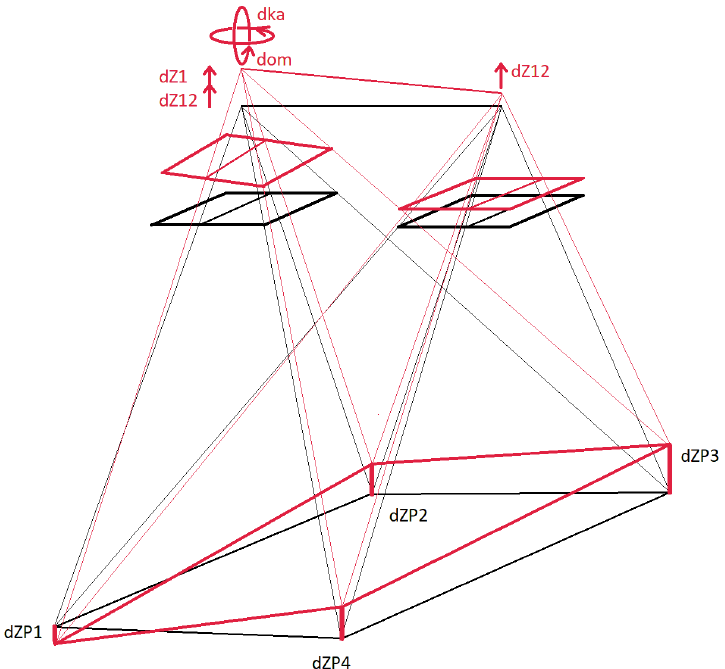
Figure 1. Stereoscopic model of height deformations from dZP1 to dZP4 caused by the errors of relative orientation parameters (ROP).